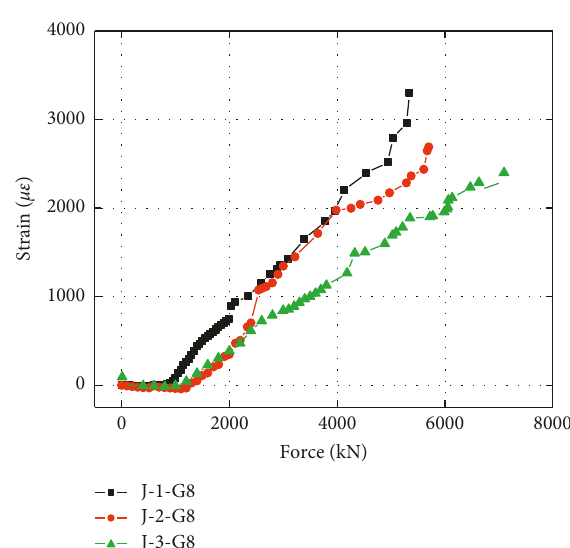
Figure 19: Strain curve of the first yield stirrup.